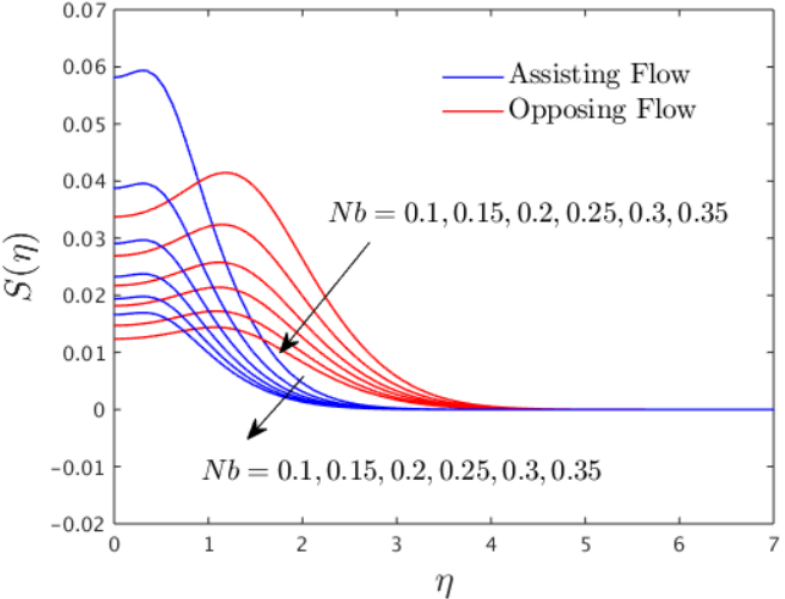
Figure 11.   S  against Nb . Figure 11. S ( η ) against Nb